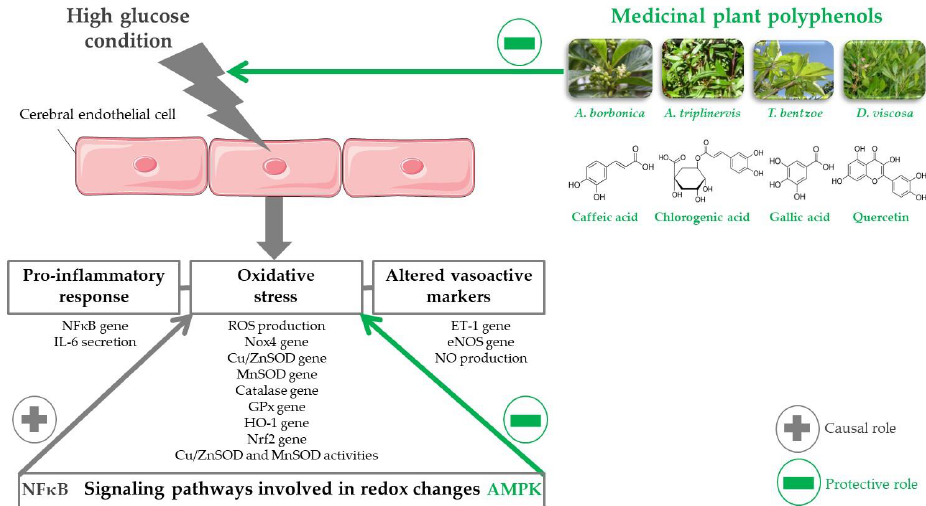
Figure 8. Overview of the molecular targets involved in the protective e ff ects of medicinal plant polyphenols on cerebral endothelial cells in hyperglycemic condition. High glucose condition increased ROS levels and deregulated key redox factors comprising Nox4, SOD, catalase, GPx, HO-1, and Nrf2. Medicinal plant polyphenols attenuated oxidative stress mediated by hyperglycemic condition. Cell preconditioning with inhibitors of signaling pathways showed the causal role of NF κ B while a protective action of AMPK on redox changes. Hyperglycemic condition promoted a pro-inflammatory status by elevating NF κ B gene expression and IL-6 secretion, and damaged ET-1, eNOS and NO vasoactive marker production. Interestingly, medicinal plant polyphenols protected against the deleterious e ff ects of hyperglycemic condition. Quercetin, ca ff eic, chlorogenic and gallic acids identified as predominant plant polyphenols exerted similar protective e ff